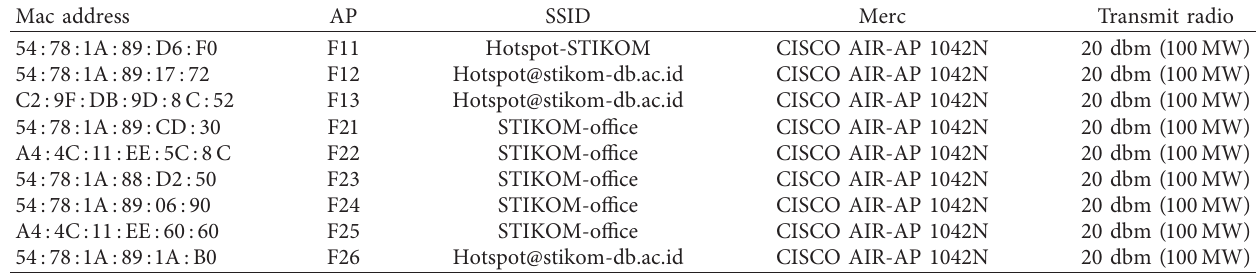
Table 1: Access point profile.